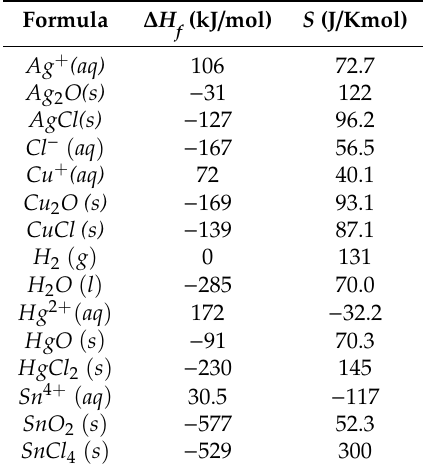
Table 6. Enthalpy of the formation and entropy values for key species.